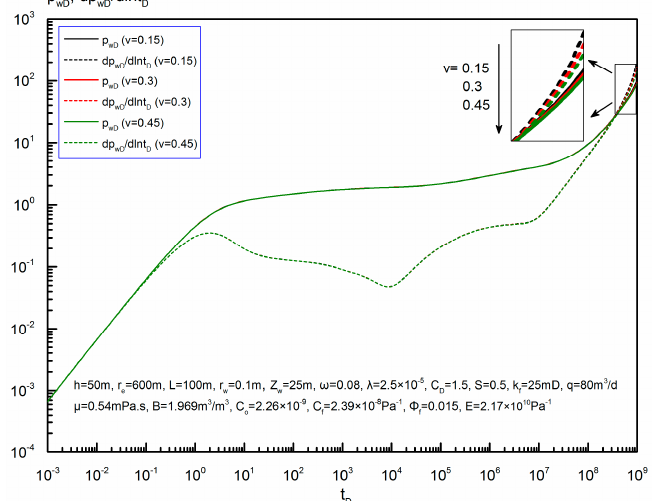
ν ) on the transient pressure behavior of H519 in North Truva